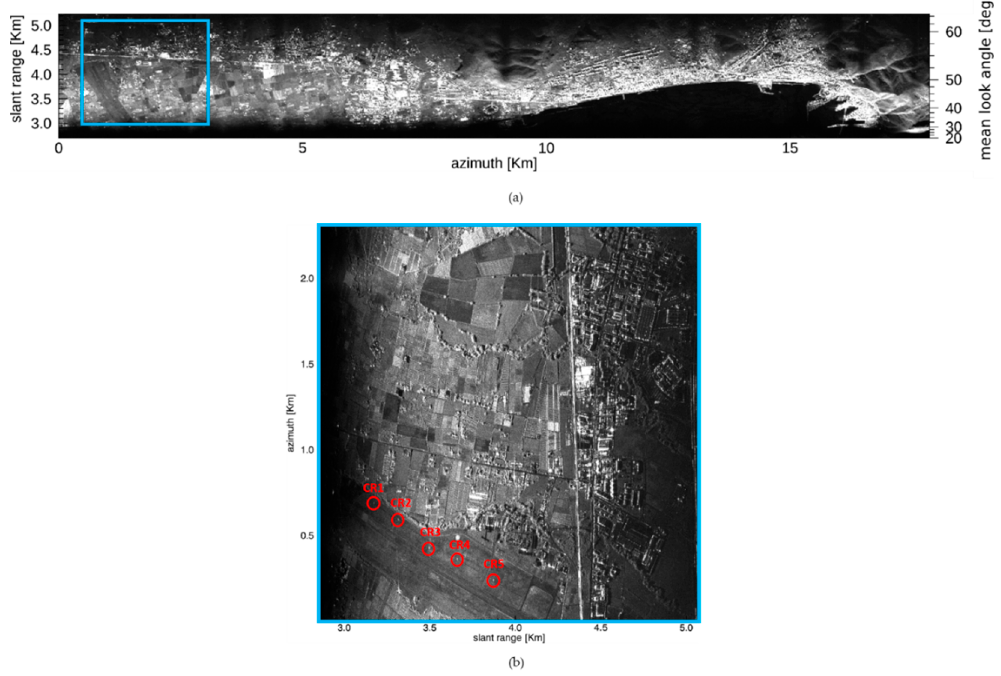
Figure 9. ( a ) Multi-look amplitude SAR images relevant to the acquired data. A 10 range × 10 azimuth pixel averaging window was applied, obtaining 15 m × 16 m pixel spacing. ( b ) Multi-look amplitude image of a patch of the entire acquired strip. A 2 range × 10 azimuth pixel averaging window was applied, obtaining 1.5 m × 1.6 m pixel spacing. Red circles indicate the Corner Reflectors’ (CRs’) positions. Table 5. SAR data processing parameters relevant to the results collected in Figure 9a,b.